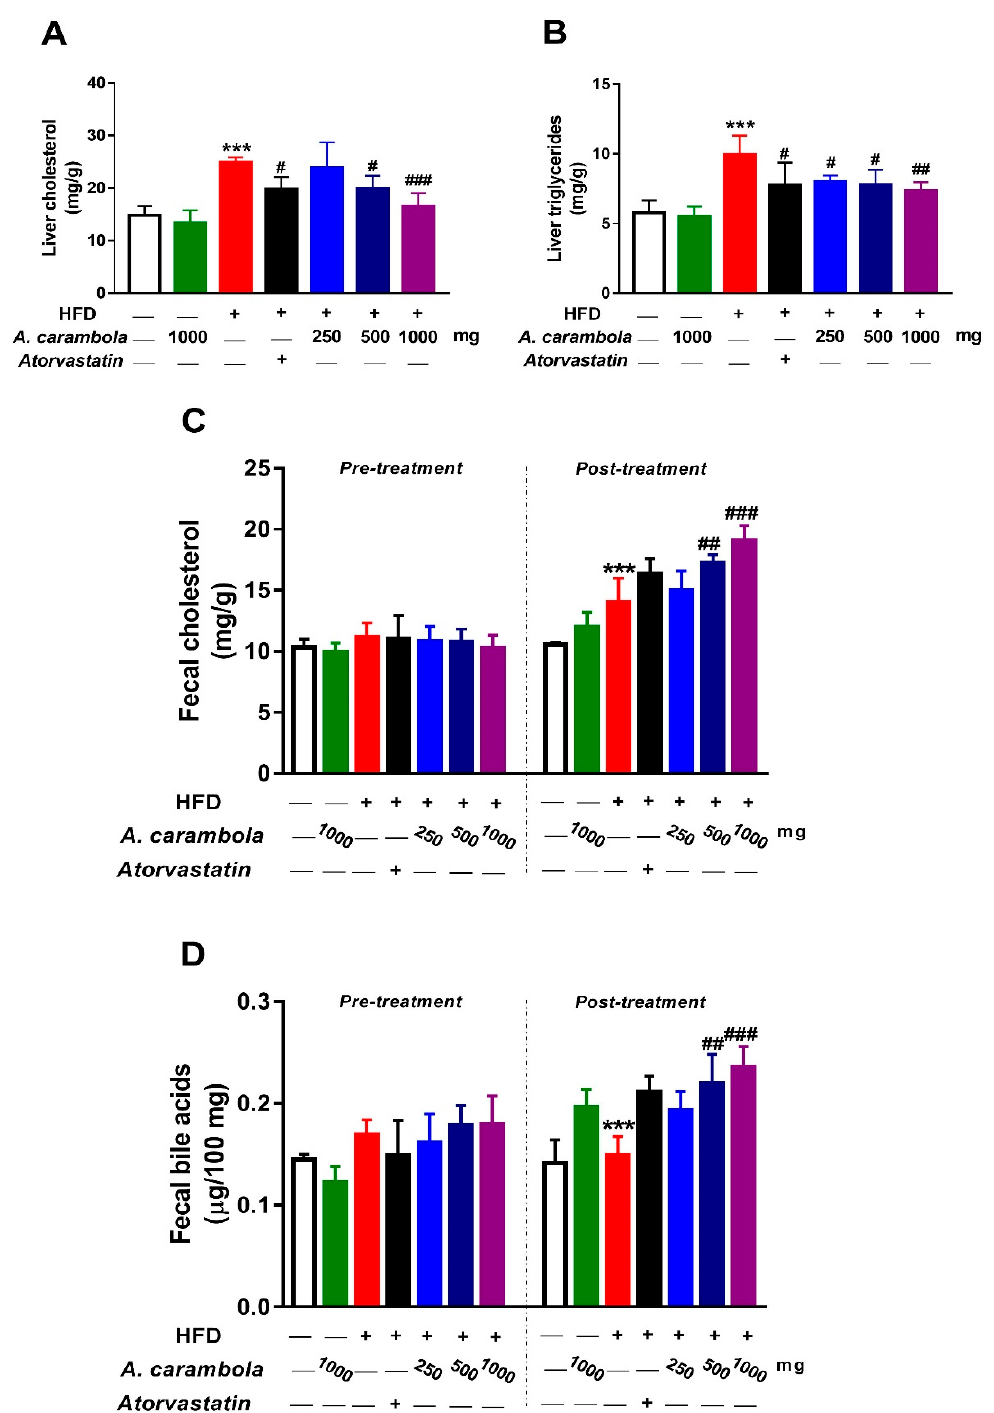
Figure 6. Effect of MEACL on levels of liver total cholesterol ( A ), triglycerides ( B ), fecal cholesterol ( C ), and fecal bile acids ( D ) in HFD-induced hyperlipidemic rats. Values are represented as mean ± SEM, n = 6. *** p < 0.001 compared to normal control. # p < 0.05, ## p < 0.01, ### p < 0.001 compared to hyperlipidemic control.